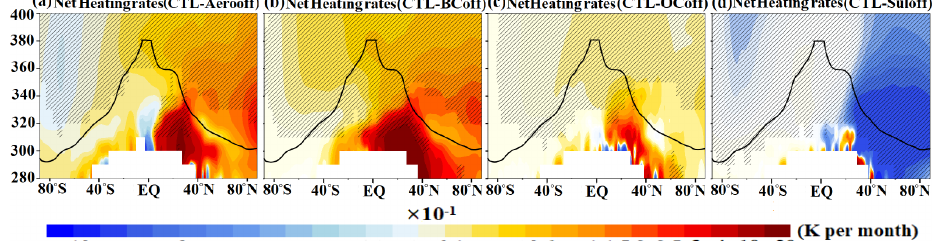
Figure 6. Meridional cross-section of heating rates (K per month) over the Indian Ocean–western Pacific (averaged 30–140 ◦ E and for the spring season for the years 2001–2016) (a) from the CTL-Aerooff simulation. (b) Same (a) but from the CTL-BCoff simulation. (c) Same (a) but from the CTL-OCoff simulation. (d) Same (a) but from the CTL-Suloff simulation. Hatched lines in (a–d) indicate the 95% signifi- cance level. A black line in (a–d) indicates the dynamical